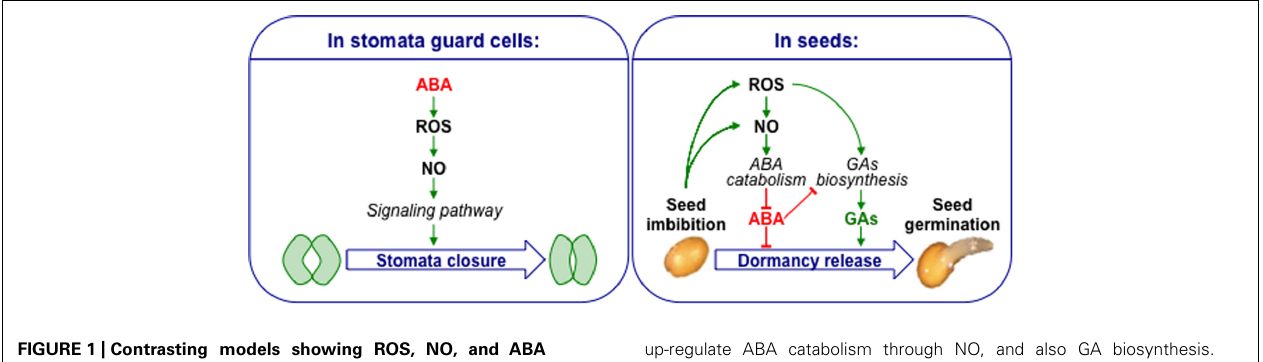
FIGURE 1 | Contrasting models showing ROS, NO, and ABA crosstalk in stomata guard cells and seeds. ABA increases ROS and NO level in guard cells leading to ABA-dependent stomatal closure. Seed imbibition leads to ROS and NO accumulation. ROS